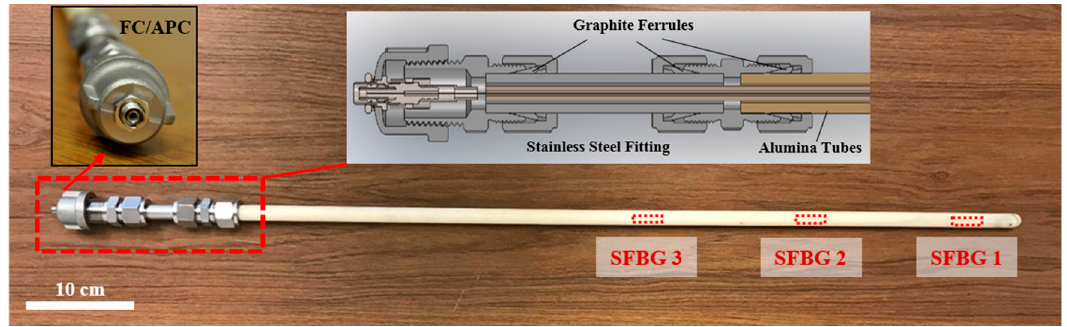
Figure 2. Working principle of wavelength-multiplexed-SFBGs temperature sensor and their spectra after fabrication at room temperature. Note: SFBG = sapphire fiber Bragg grating.